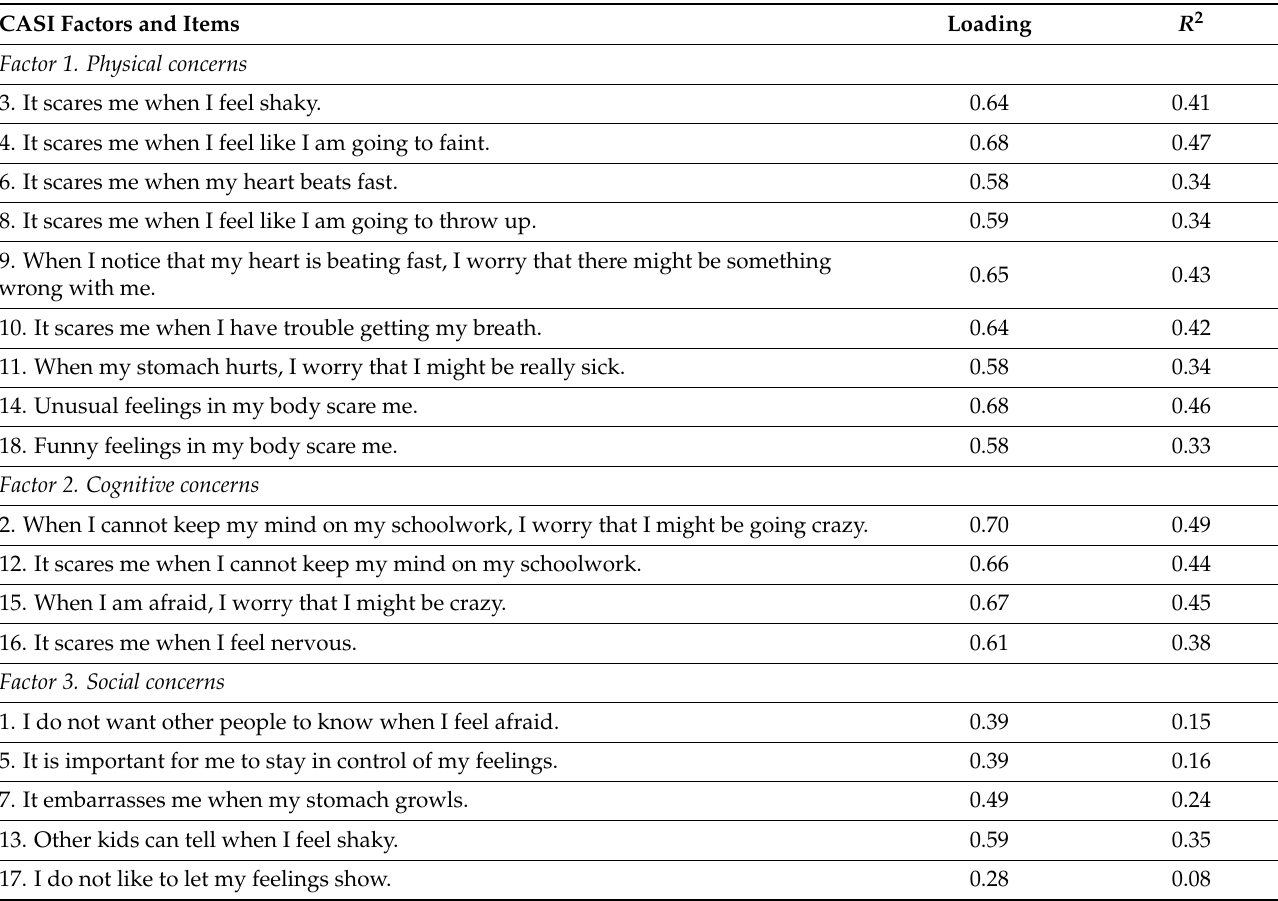
Table 4. Confirmatory factor analysis of the CASI: fully standardized coefficients (loadings) and squared multiple correlations for the correlated 3-factor model ( N = 1655).